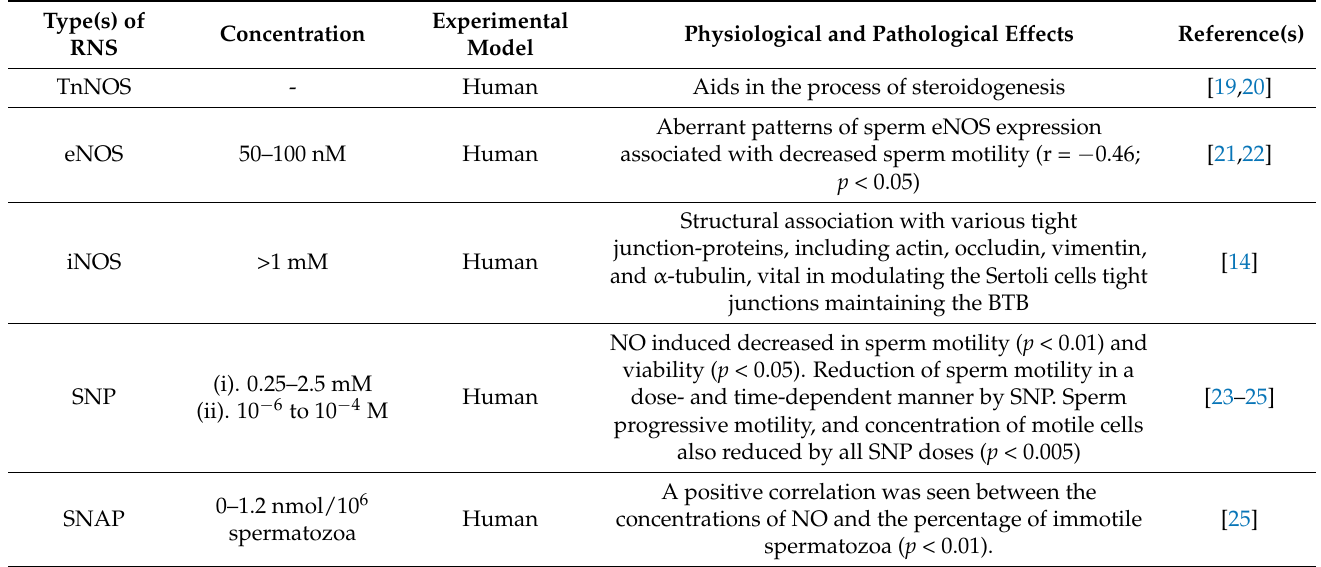
Table 1. Physiological and pathological effects of reactive nitrogen species (RNS) on male